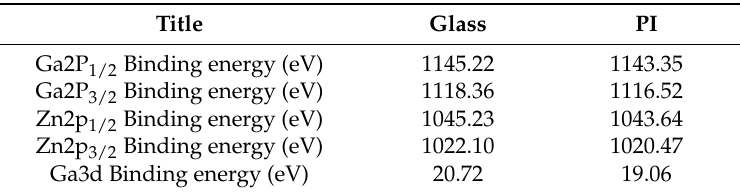
Table 3. Comparison of binding energies of Ga2p 3/2 , Ga2p 1/2 , Zn2p 3/2 , Zn2p 1/2 , and Ga3d peaks for GZO thin films on different substrates.